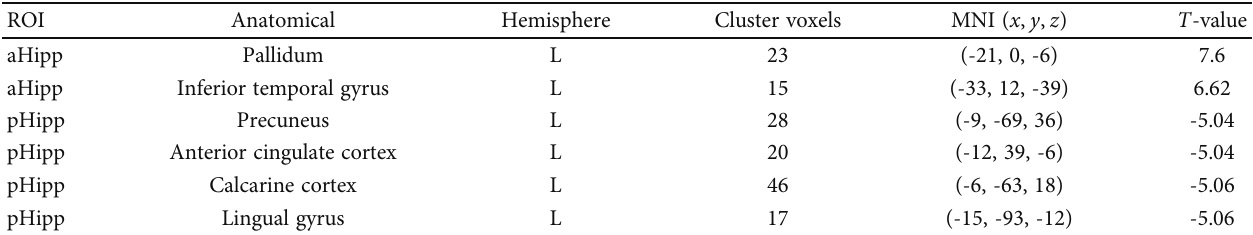
Figure 1: The FC di ff erent regions between aHipp and pHipp. (a) Statistical results in the left hemisphere. (b) Statistical results in the right hemisphere. The red parts indicated that the FC of aHipp was signi fi cantly greater than that of pHipp. The blue parts indicated that the FC of pHipp was signi fi cantly greater than that of aHipp ( p < 0 : 05 , FWE corrected). Table 1: The fi nal signi fi cant FC regions of aHipp.L and pHipp.L within the left hemisphere.